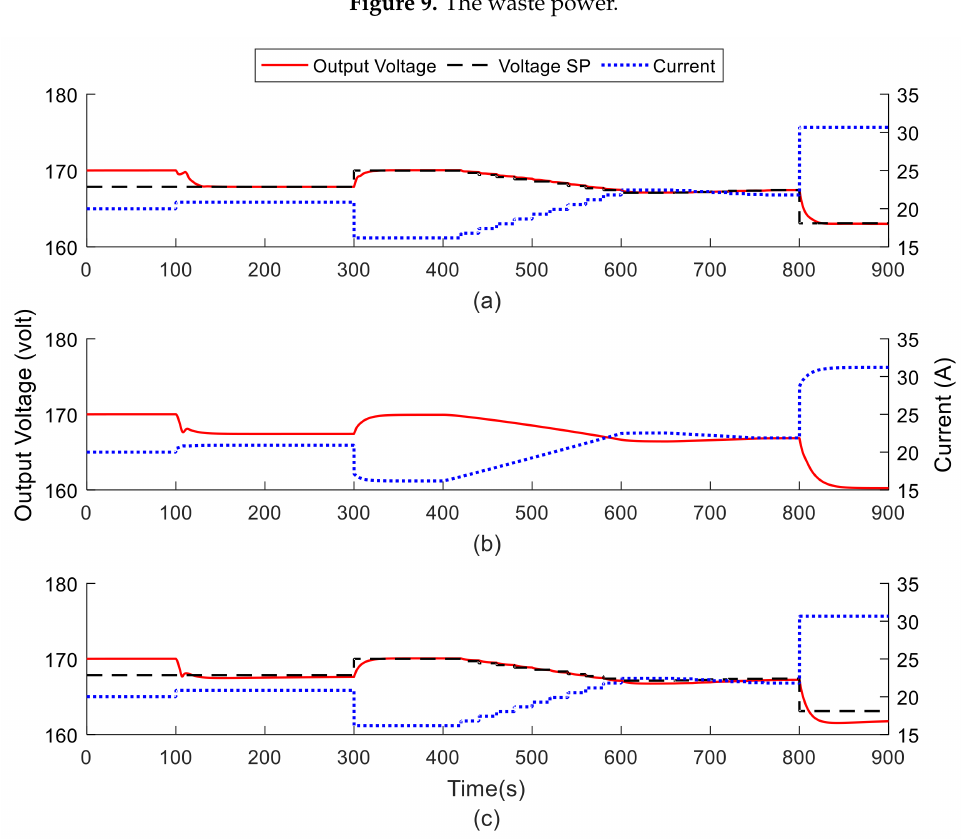
Figure 10. The output voltage and current of SOFCs. ( a ) Set point (SP) Scheduler + L1-MPC; ( b ) Only PID; ( c ) SP Scheduler +